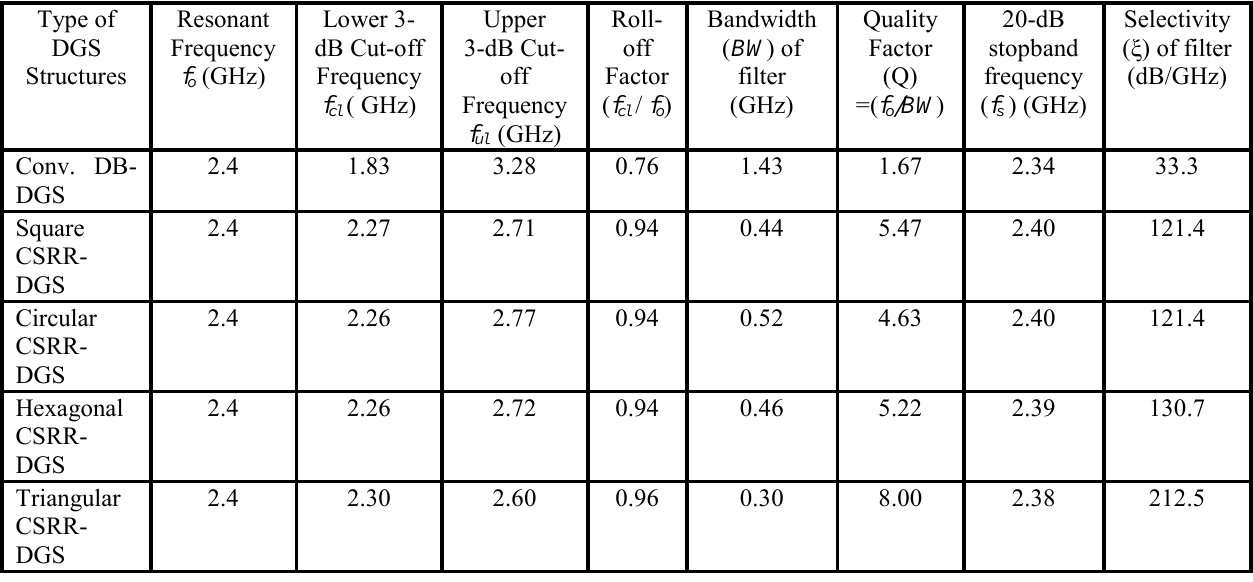
Table 2: Comparison of performance of microstrip bandstop filter with various CSRR-DGS geometries Type of